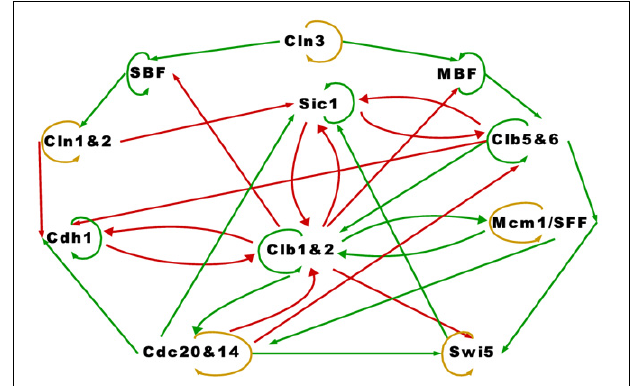
FIGURE 1 | The simplified yeast cell-cycle